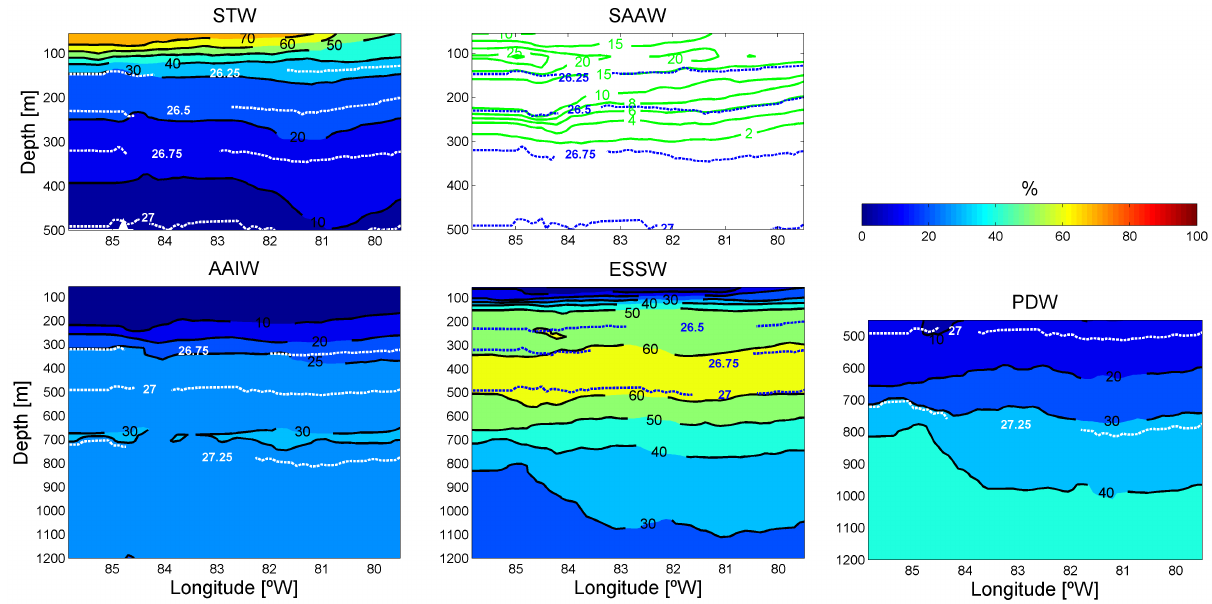
Fig. 3. Water mass distribution (%) along the 14 ◦ S section between 85 ◦ 50 0 W and the continental shelf for the M77 cruise (February 2009), for subtropical water (STW), subantarctic water (SAAW), antarctic intermediate water (AAIW), equatorial subsurface water (ESSW) and pacific deep water (PDW) as defined in Table 1. Selected isopycnals are shown as dotted white/blue